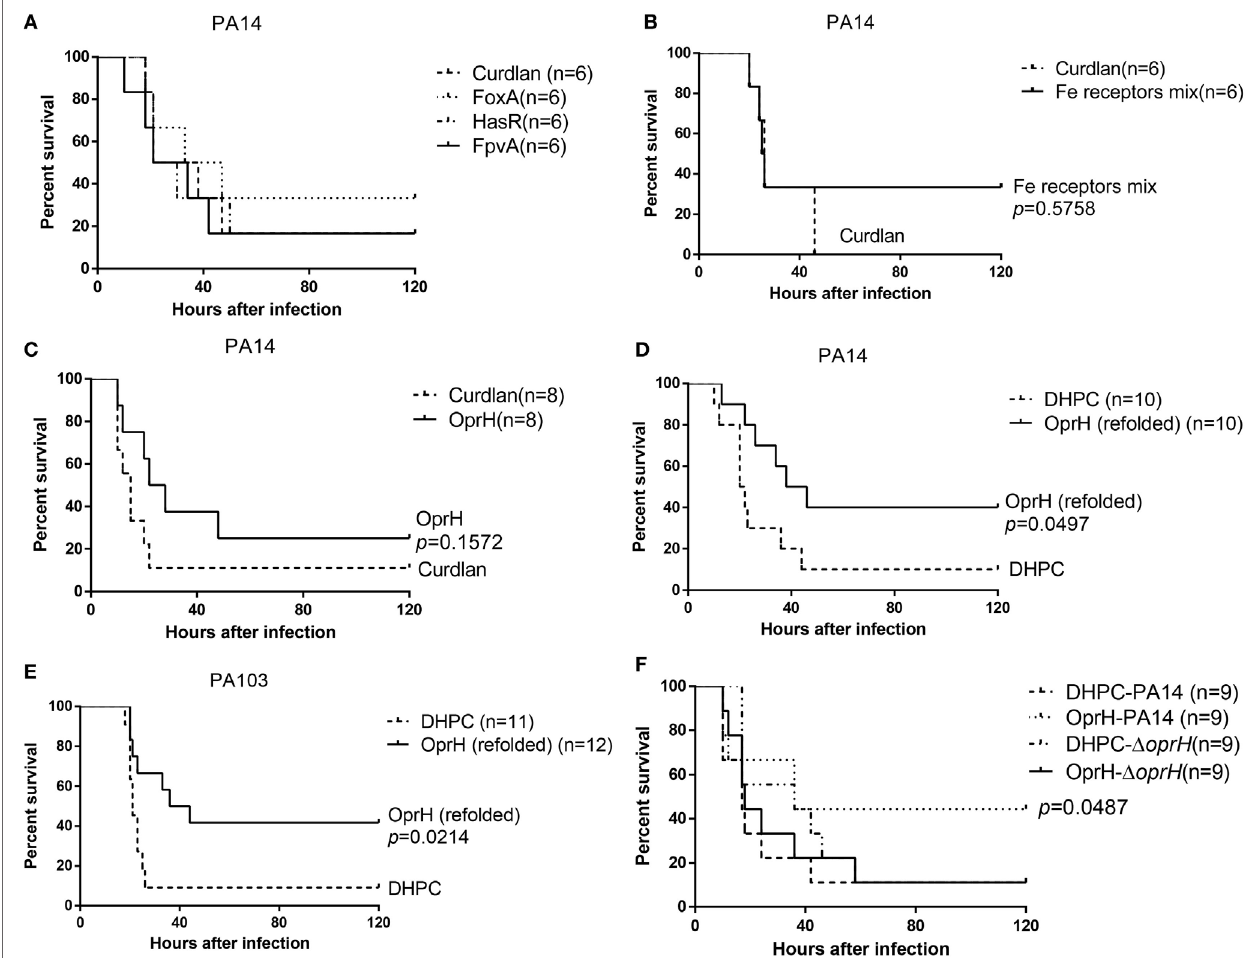
FigUre 4 | Survival rates of immunized mice. Mice were immunized with FpvA, HasR, and FoxA individually (a) , the mixture of purified FpvA, HasR, and FoxA (B) , or purified OprH (c) . Curdlan was used as the adjuvant. The immunized mice were challenged with wild-type PA14 (2 × 10 7 CFU per mouse) intranasally. (D) Mice immunized with OprH refolded in DHPC with curdlan or curdlan alone were challenged with wild-type PA14 (2 × 10 7 CFU per mouse) or PA103 (2 × 10 6 CFU per mouse) (e) or the PA14 Δ oprH strain (F) . The mice were monitored for 5 days. p Values were calculated by log-rank test. The p value in (F) is the comparison between PA14 or the Δ oprH challenged OprH immunized